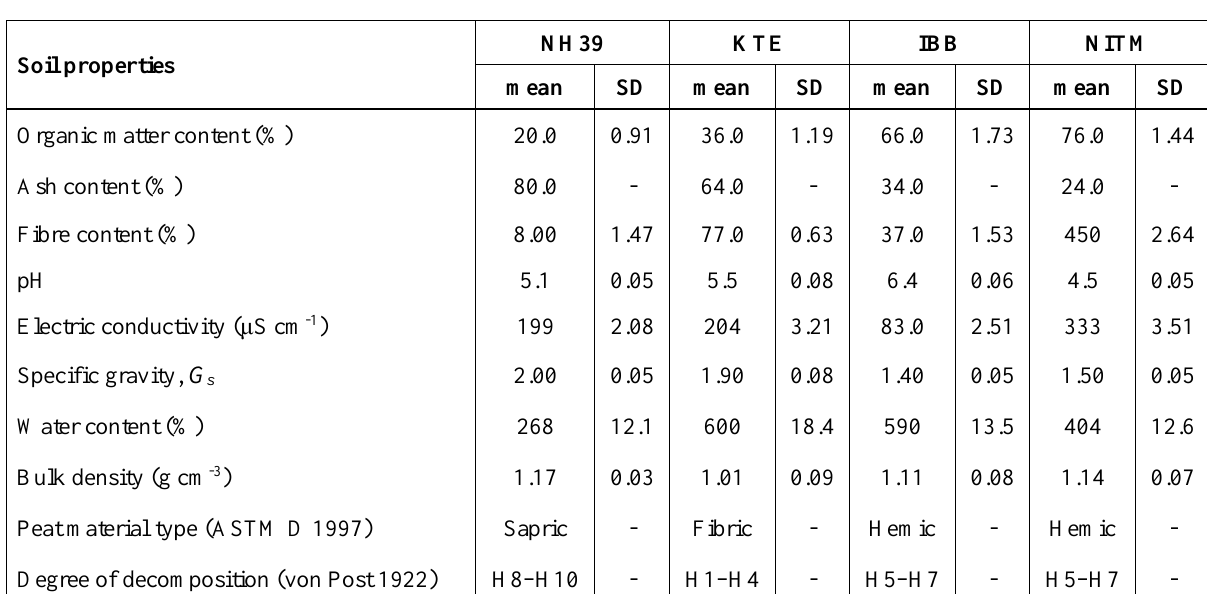
Table 2. Physicochemical properties of Northeast Indian peats (n = 3), adapted from Paul et al . (2018). SD = standard